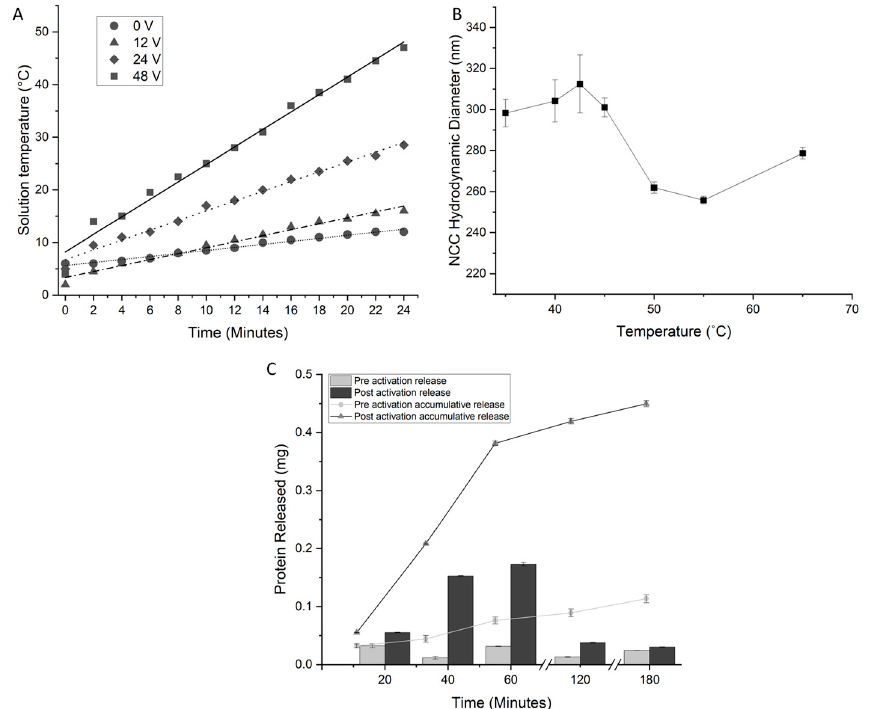
Figure 5. Properties of the NCC. ( A ) The induction heating rates of the NCC at a concentration of 100 mg/mL observed at differing AC circuit voltages from 0–48 V. ( B ) The temperature-dependent hydrodynamic diameter of NCC, as measured by dynamic light scattering. Swelling of the complex is observed until an LCST of 42.5 °C is reached, at which the hydrodynamic diameter decreases. ( C ) The release profile of BSA from protein-loaded NCC. Stimulated and passive releases are shown, as well as cycled and accumulative releases. The protein content was measured by a Bradford protein assay.